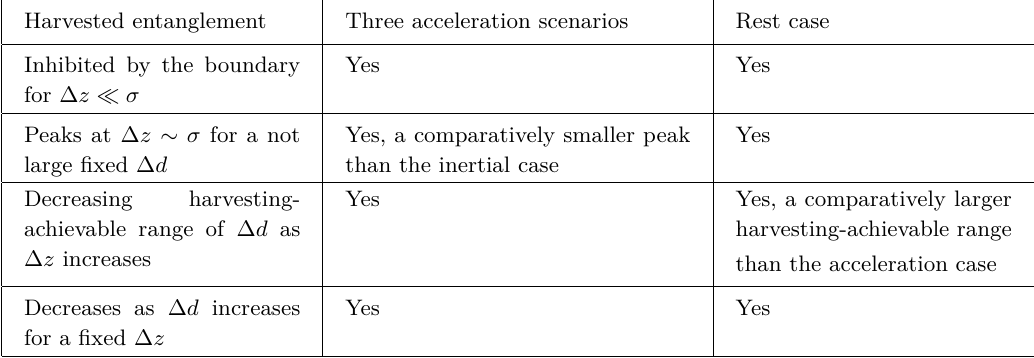
Table 1. Main results of the boundary influence for accelerated and inertial rest detectors.